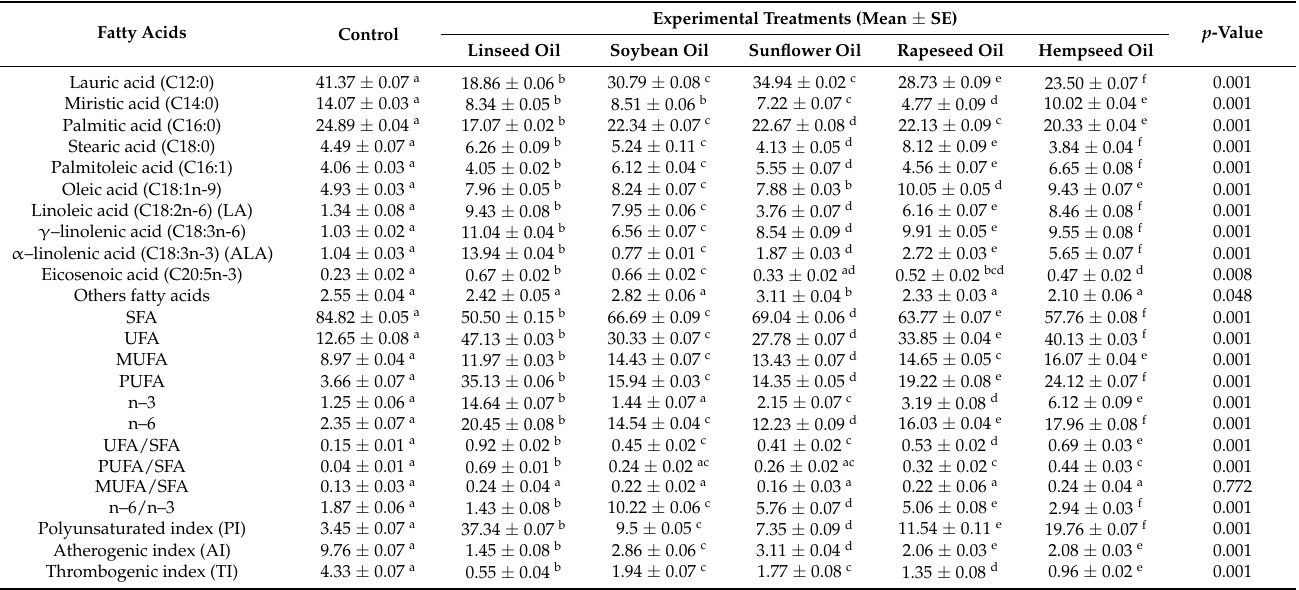
Table 4. The influence of vegetable oil inclusion in the diets of 15-day-old larvae on the fatty acid profile of fats (% of